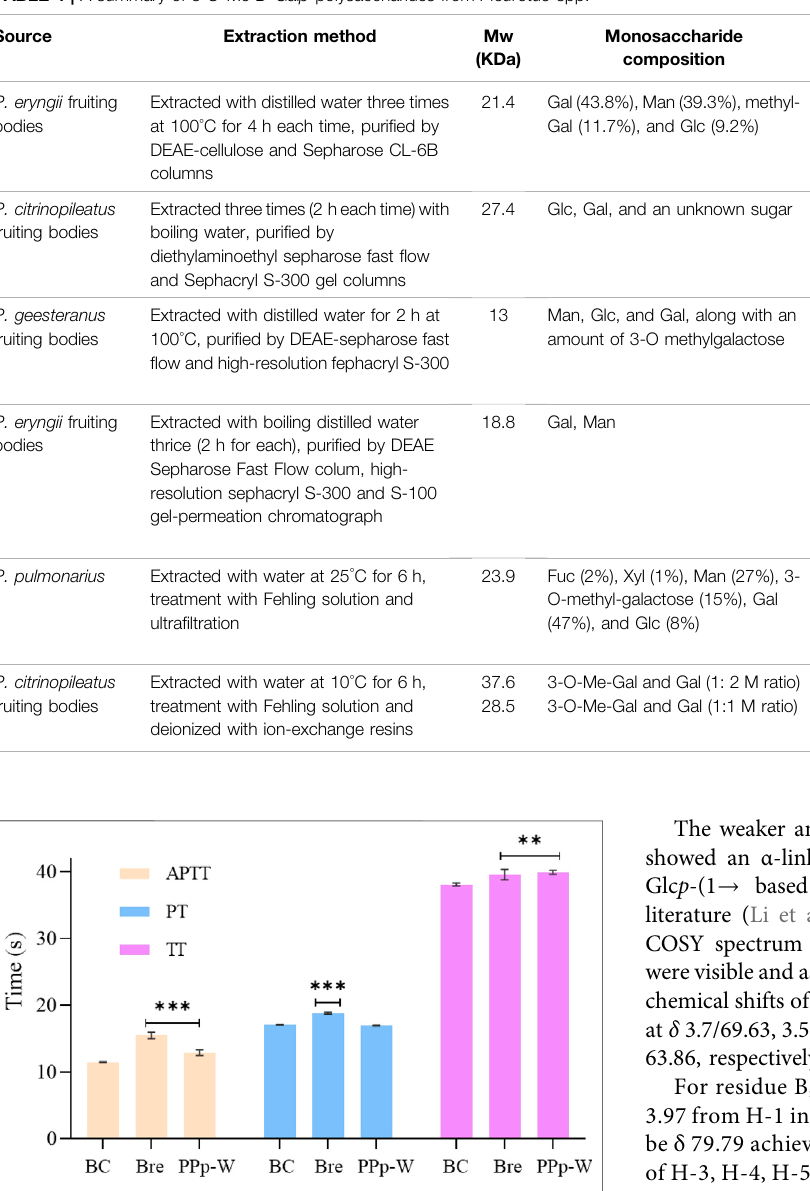
FIGURE 8 | Effects of PPp-W on activated partial thromboplastin time (APTT), prothrombin time (PT), and thrombin time (TT) in vitro ( n = 3) (Compared with BC, *** p < 0.001 ** p < 0.01 * p <